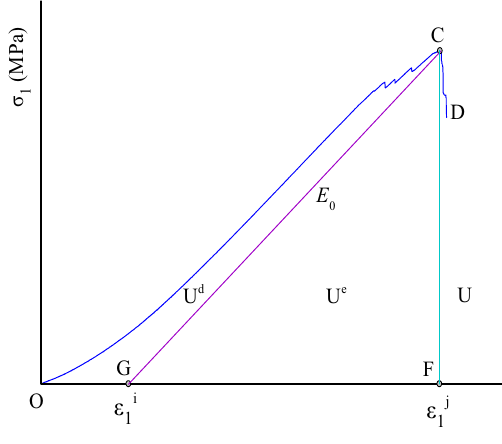
Fig. 5 Relationship between dissipated energy and releasable elastic performance during uniaxial